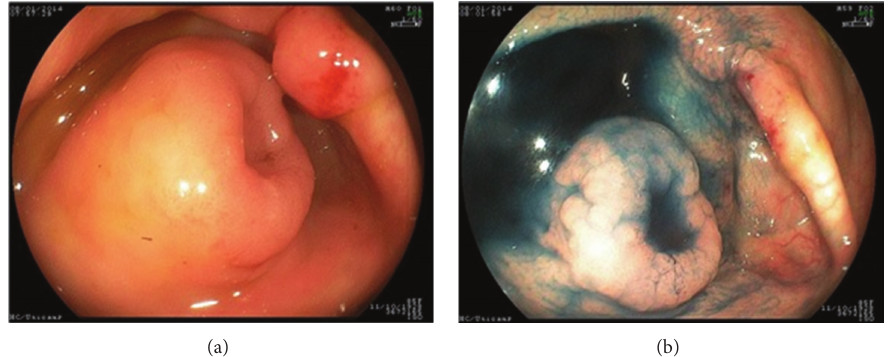
Figure 1: (a) A colonoscopic view of the protruding adenoma surrounding the ostium of the appendix. (b) The same image after chromoscopy with indigo carmine.